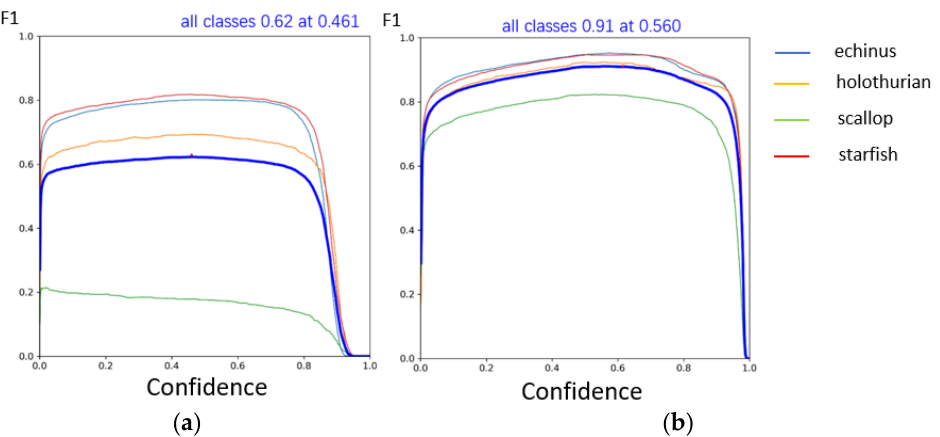
Figure 15. F1-score curve of the models trained with and without random expansion under di ff erent con fi dence levels: ( a ) F1-score curve of the model trained without random expansion; and ( b ) F1-score curve of the model trained with random expansion.